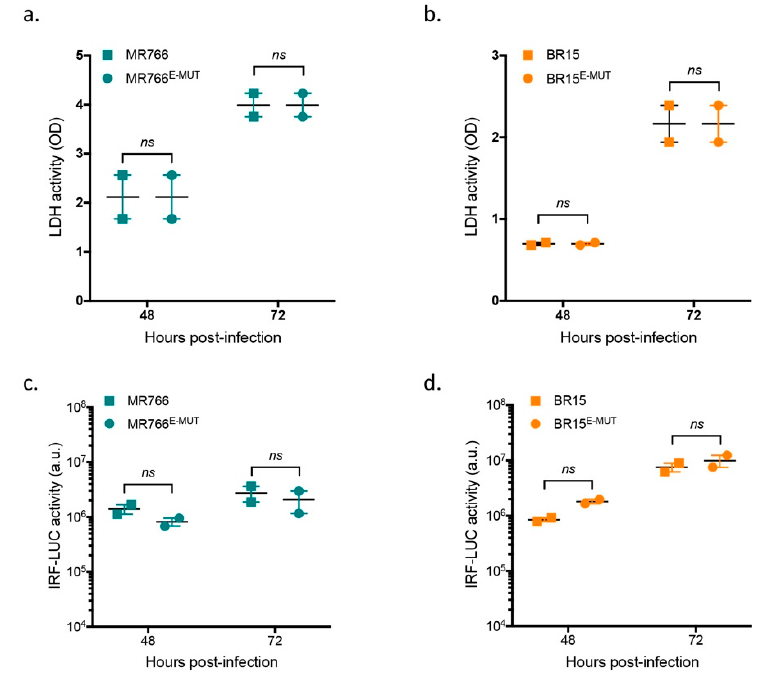
Figure 3. Analysis of infection-induced cell death and immune responses. A549-Dual ™ were infected with BR15 E-MUT and MR766 E-MUT and parental clones at MOI of 1. In ( a ) and ( b ), LDH activity was measured at 48 and 72 hpi respectively. Values represents mean and standard errors of two independent experiments in triplicates. In ( c ) and ( d ), analysis of IRF pathway activation in response to viral infection. Activity of secreted Lucia luciferase was measured using QUANTI-Luc substrate at 48 and 72 hpi. Results are expressed as raw data of luminescence arbitrary units. Error bars represent standard errors of two independent experiments in triplicates. ns : not significant.